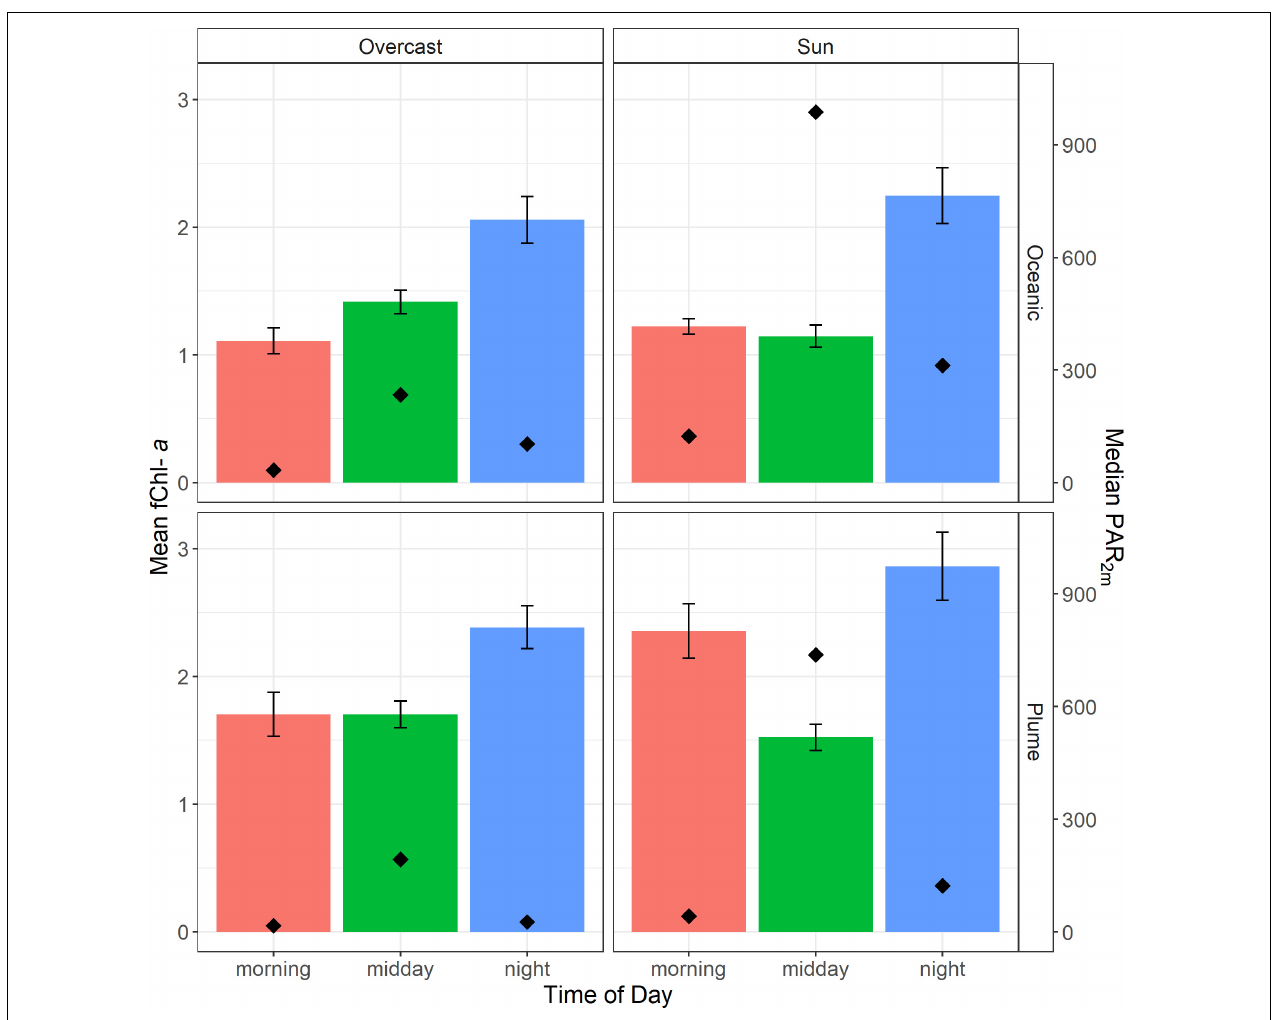
FIGURE 5 | Average chlorophyll-a concentration obtained by the FerryBox across three time periods and in sunny and overcast conditions. Error bars represent 95% confidence intervals for mean Chl- a concentration. The top row shows average conditions in oceanic water ( n = 4927) and the bottom row shows average conditions in the plume ( n = 5679). Median PAR 2m is shown on the secondary y-axis and is represented by black diamonds. TABLE 2 | Comparison of error statistics for each step of the correction procedure: (1) biofouling correction (fChl-a), (2) adjusted for sensor bias (f’Chl- a ), and (3) the three NPQ correction methods. MAE Bias MAE Plume Bias Plume MAE ocean Bias